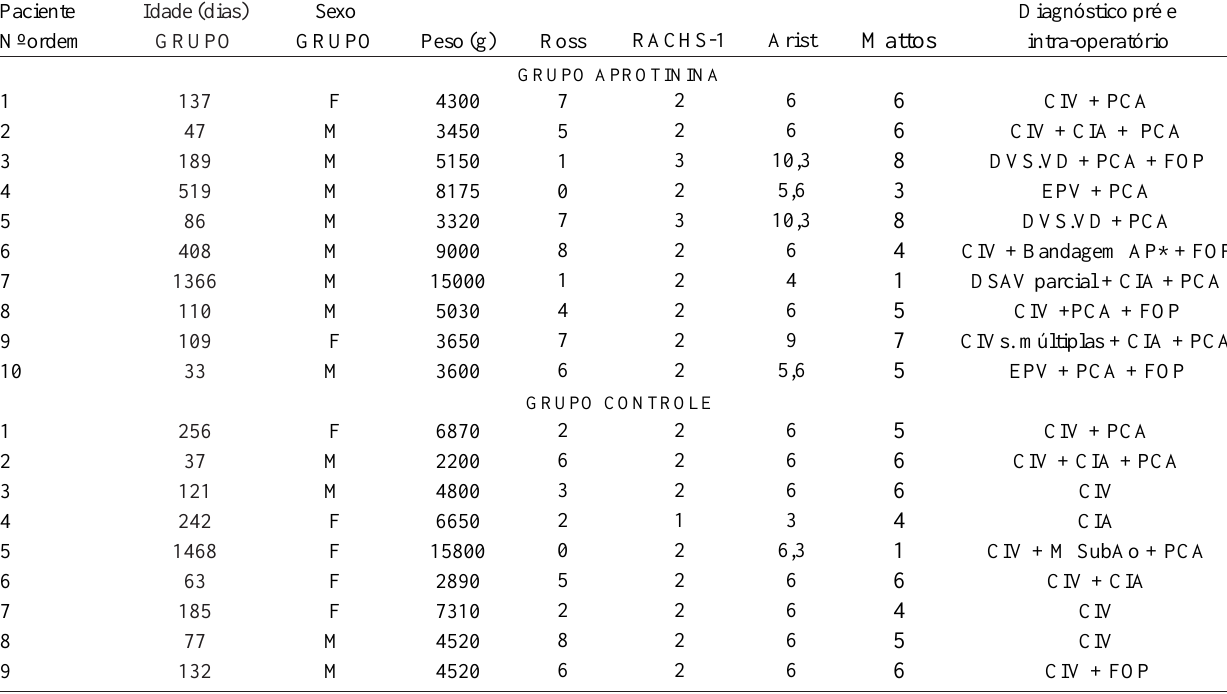
Tabela 2. Idade (dias), sexo, peso (g), escores pré-operatórios de Ross, RACHS-1 e básico de Aristóteles e índice clínico-cirúrgico de Mattos dos pacientes operados com os respectivos